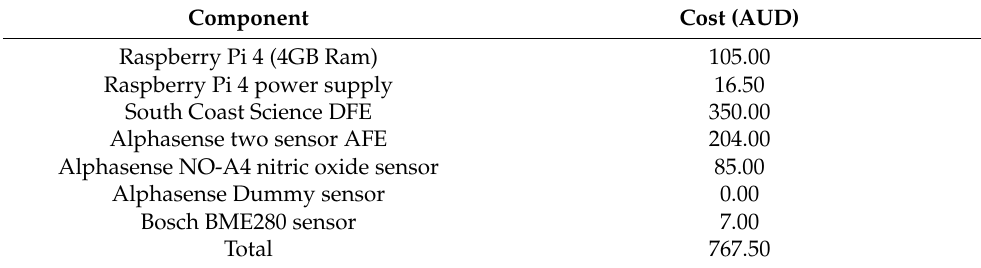
Table 2. Breakdown of sensor system component